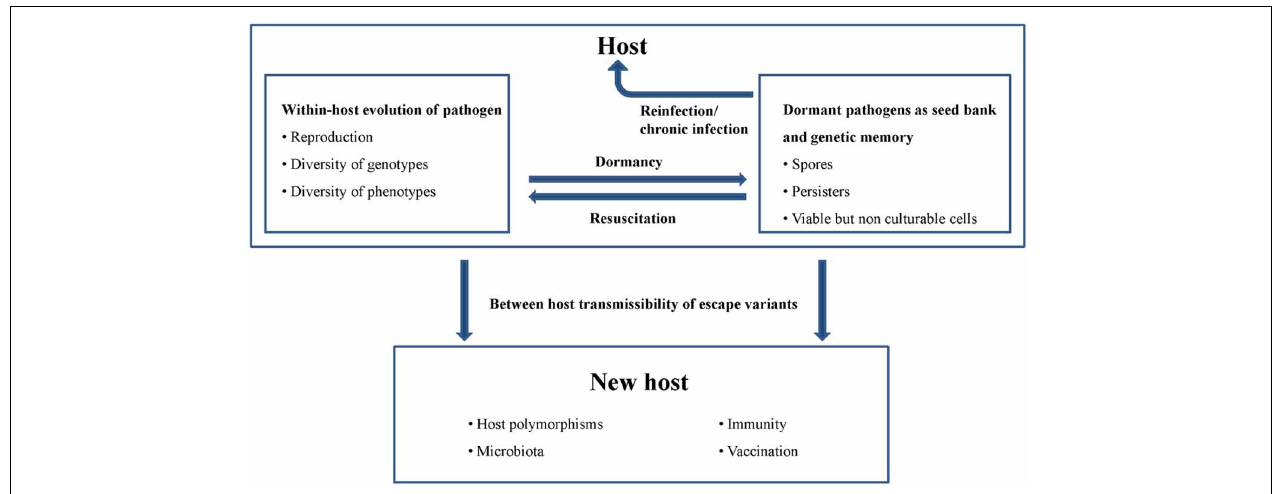
FIGURE 2 | Genotypic and phenotypic diversity of pathogens and bacterial dormancy strategies contribute to within-host evolution, chronic infections, genetic memory and between host transmissibility.